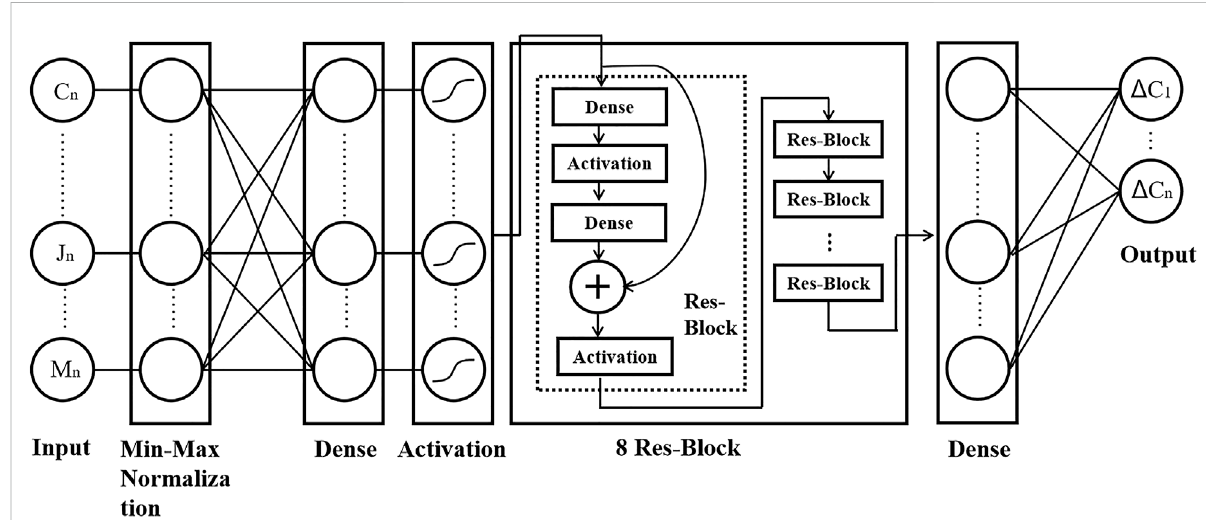
FIGURE 1 Structure diagram of neural network emulator inthis study. C n represents theinitial concentration of 47 gas phase species, M n represents three meteorological parameters (temperature, relative humidity, and air pressure), and J n represents 20 photolysis